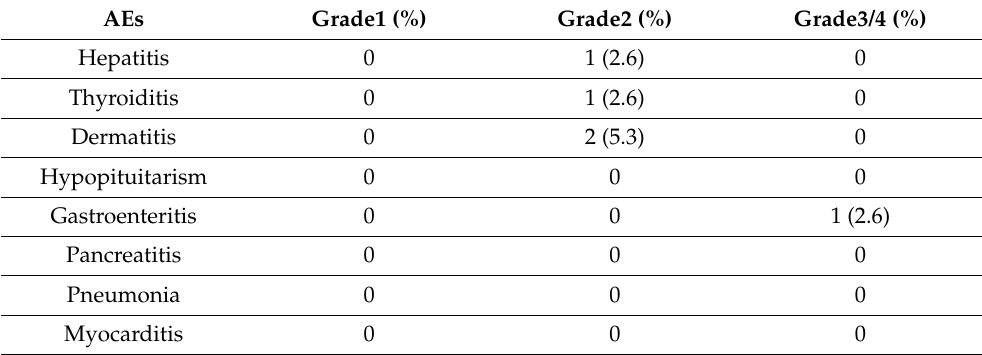
Table 4. Adverse events (AEs) of ICIs plus targeted